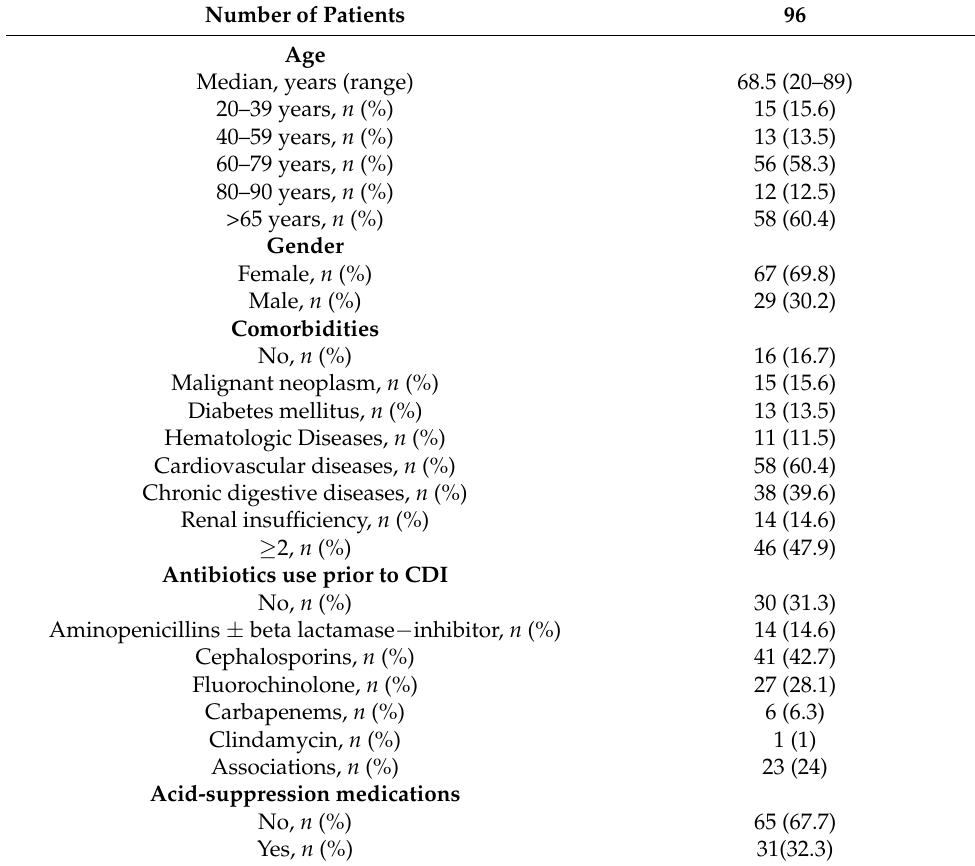
Table 1. Demographic and clinical characteristics of the